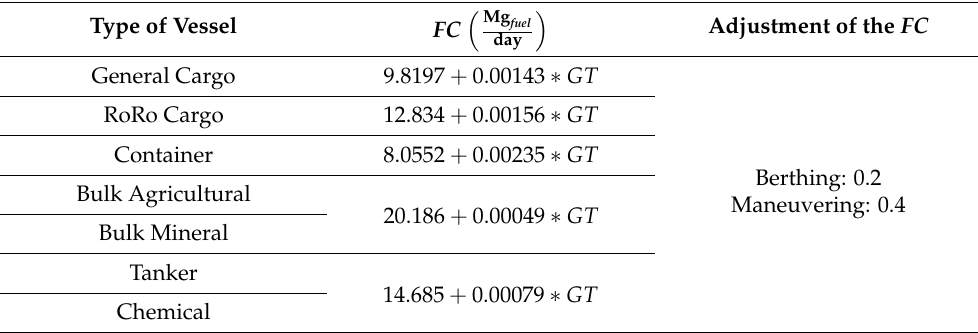
Table 4. Fuel consumption by type of ship/adjustment (Trozzi and Vaccaro [13]).